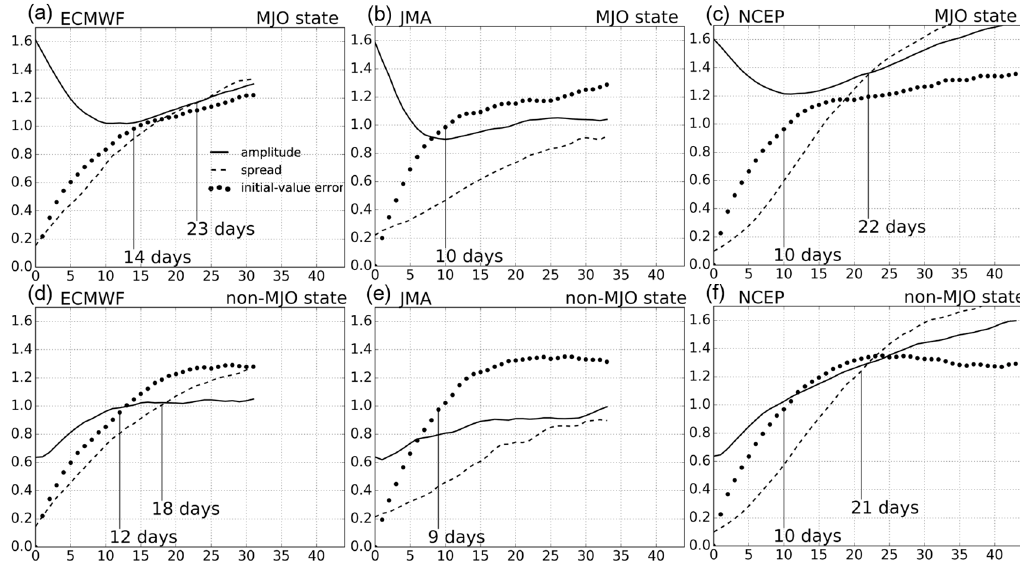
Figure 6. ( a – c ) MJO amplitude (solid line), ensemble spread multiplied by √2 on the MJO phase space (dashed line), and a maximum possible value of initial-value error evaluated with the method proposed in this paper (dotted line), averaged over forecasts of which the MJO amplitude initially exceeds unity for ( a ) ECMWF, ( b ) JMA and ( c ) NCEP models. The prediction limit (day) is denoted as the vertical line for the new and conventional methods, if any. Figures ( d – f ) are the same as ( a – c ), but for forecasts from the initial state with the MJO amplitude less than unity.